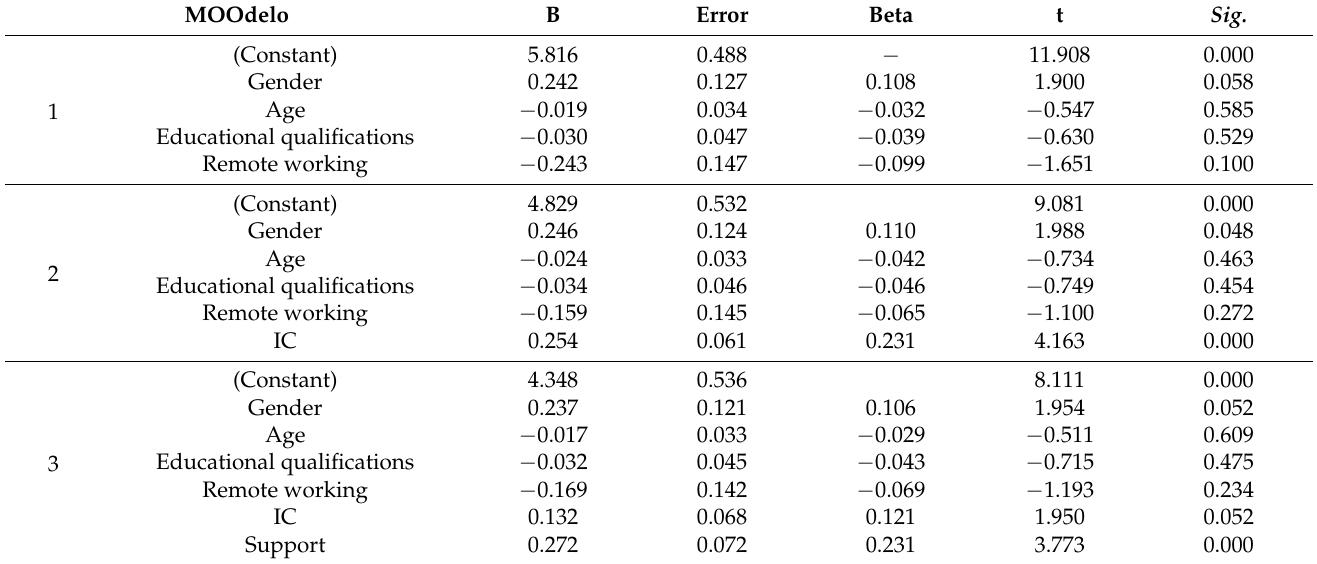
Table 2. Regression